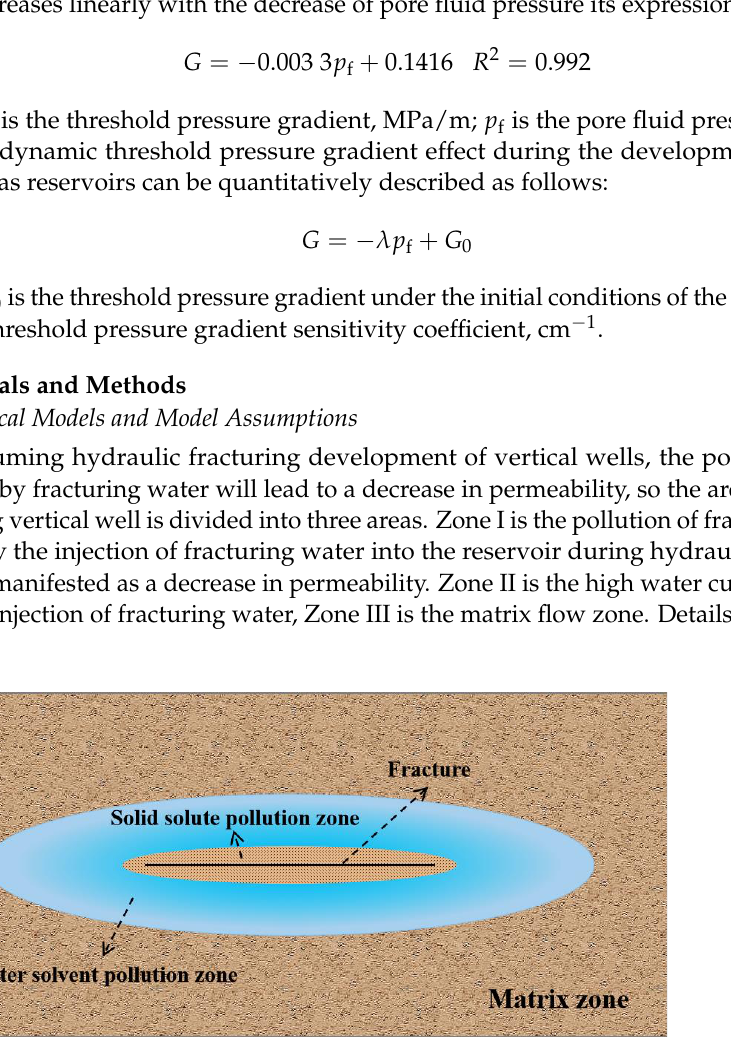
Figure 5. Schematic diagram of fracturing development zones for water-bearing underground gas reservoirs considering fracturing water